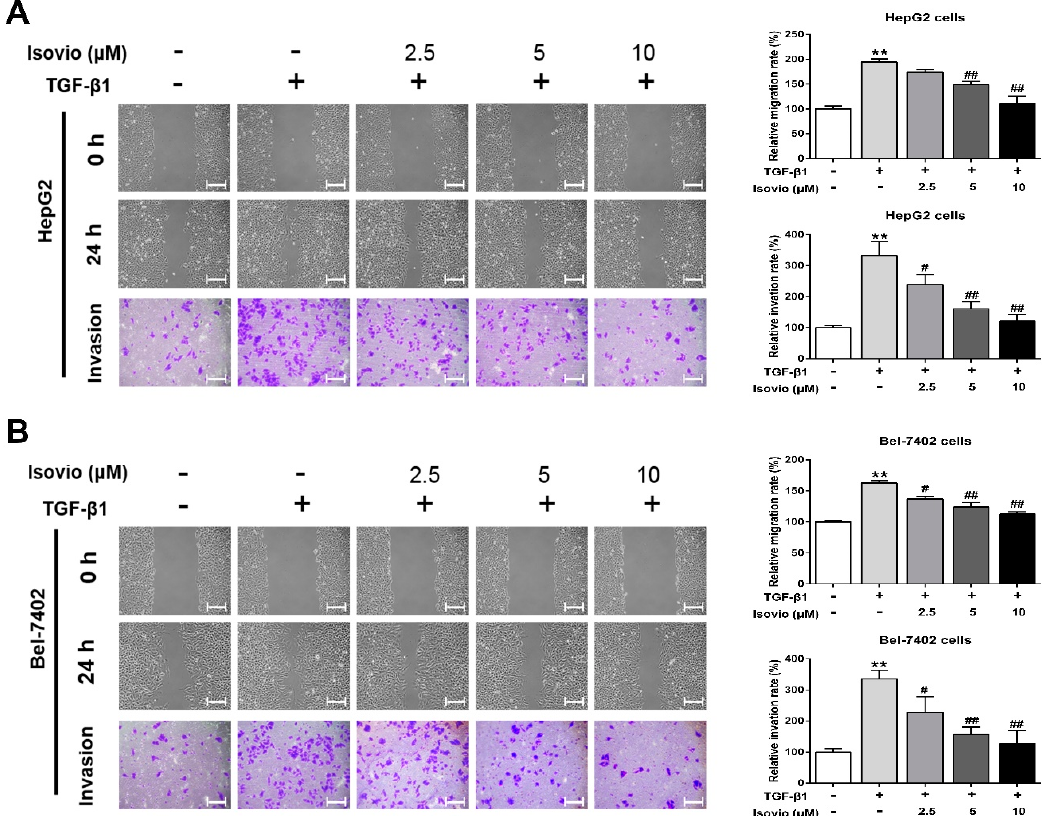
Figure 3. Effects of isoviolanthin on TGF- β 1-induced migration and invasion of HCC cells. ( A ) HepG2 and ( B ) Bel-7402 cells were pretreated with 10 ng/mL TGF- β 1 for 48 h, and then treated with isoviolanthin (2.5 µM, 5 µM, and 10 µM) for the last 24 h. The migration and invasion of HepG2 and Bel-7402 cells were measured by wound healing and transwell assays. Scale bars: 100 µm. Representative images and bar graphs (mean ± SD) are shown, n = 3. The magnification is ×100. ** p < 0.01 versus the control group; # p < 0.05, ## p < 0.01 versus the TGF- β 1 group.